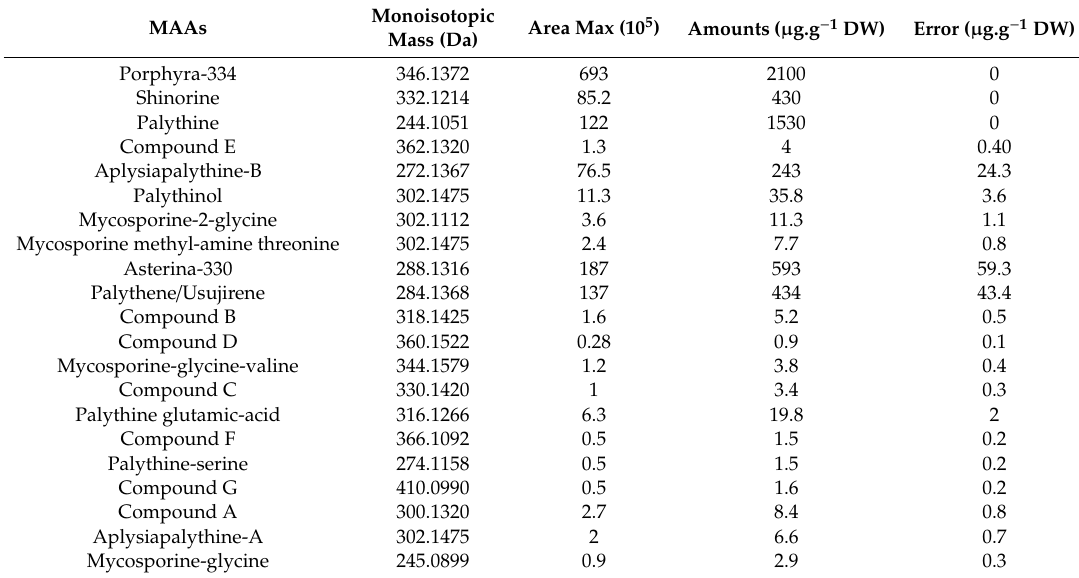
Table 7. Semi-quantitative analysis of MAAs detected in Gymnogongrus devoniensis . Amounts of MAA